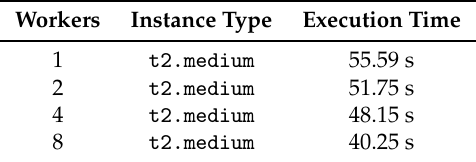
Table 4. Execution time of a single iteration as cluster size increases (each Apache Spark worker runs on a separate